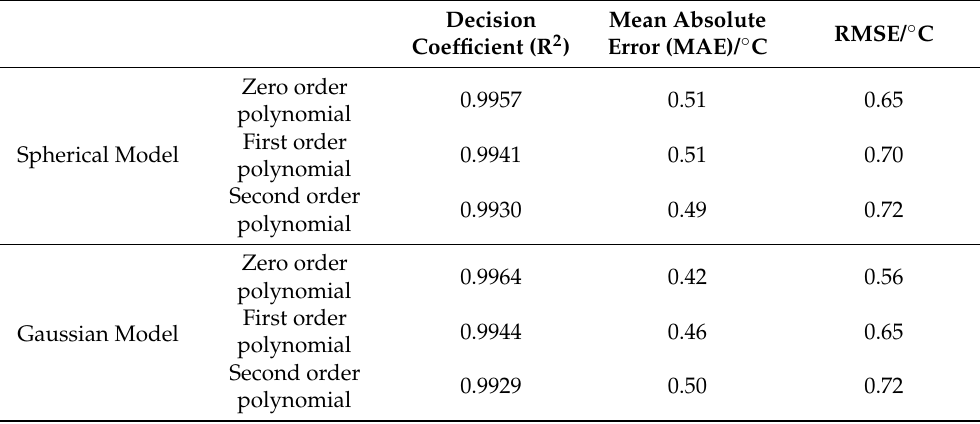
Table 2. Different model fitting